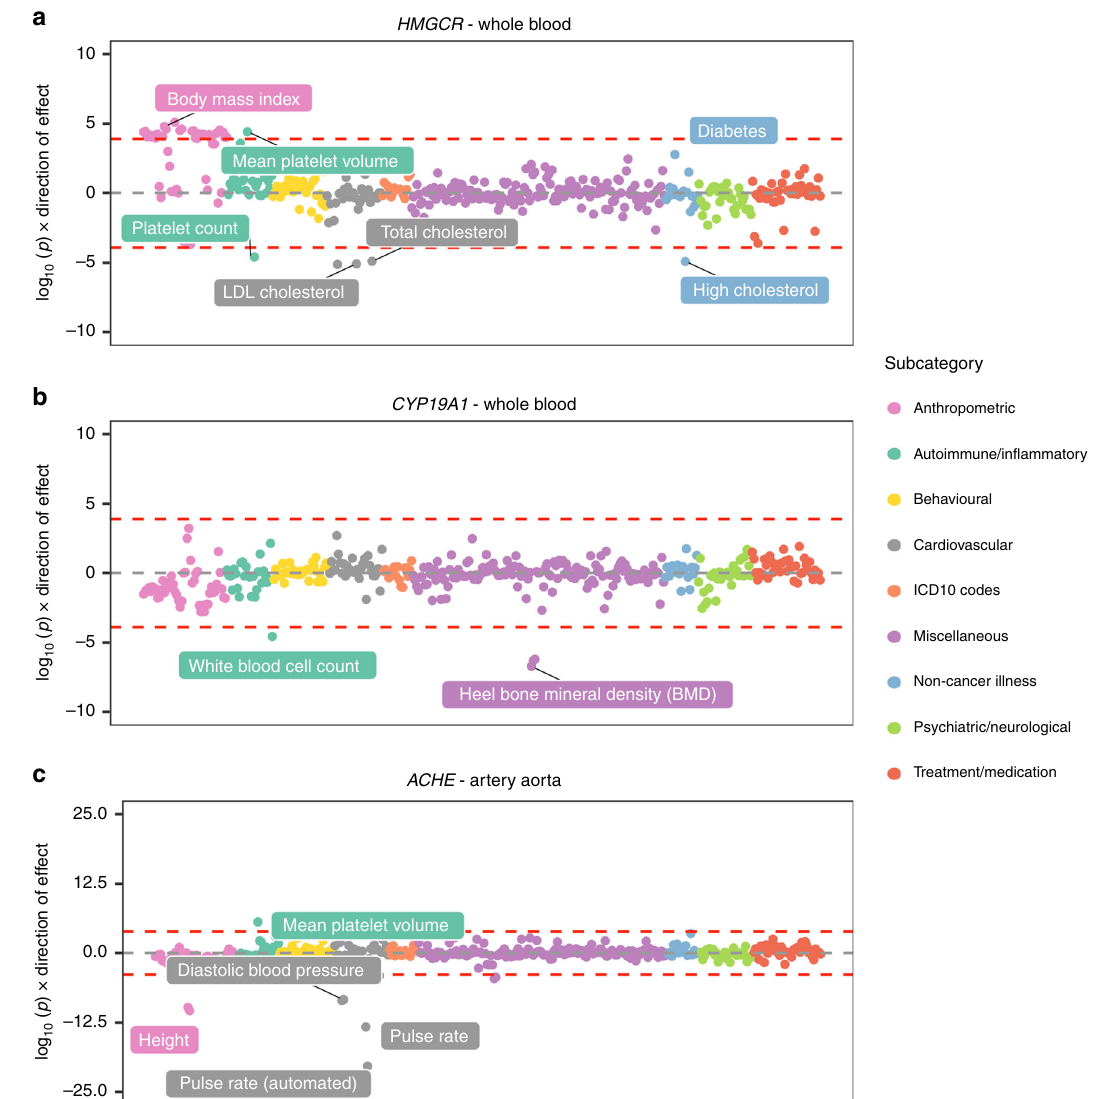
Fig. 6 Miami plots representing phenome-wide associations between genes targeted for therapeutic intervention. a HMGCR associations re fl ect reported consequences of statins, b CYP19A1 associations support adverse on-target side effects on bone mineral density, and c ACHE associations demonstrate scope for repurposing opportunities (e.g., possible inhibition to reduce blood